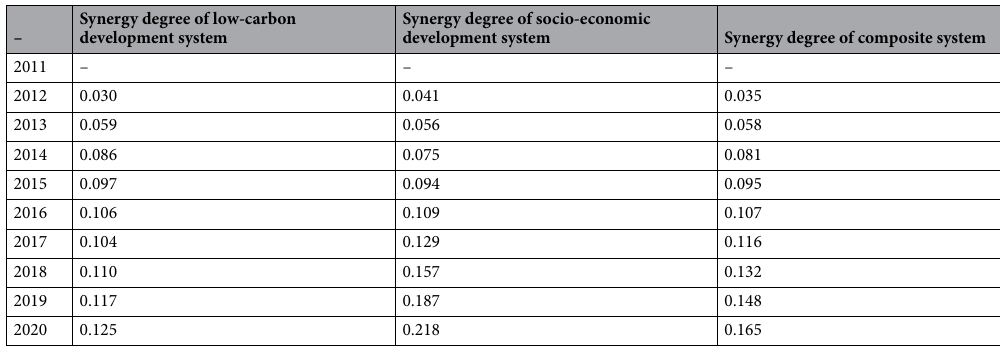
Table 3. Synergy degree in Anhui Province from 2011 to